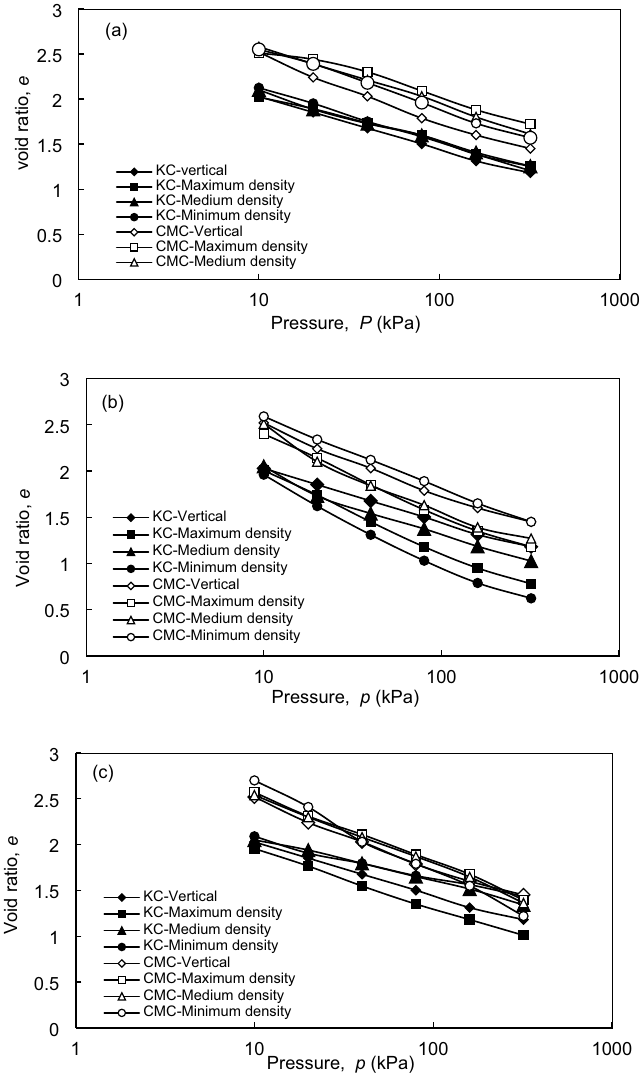
Fig. 4 e log p curve with vertical and radial drainage using (a) Sand (b) Quarry dust (c) Coir pith at various densities for KC and